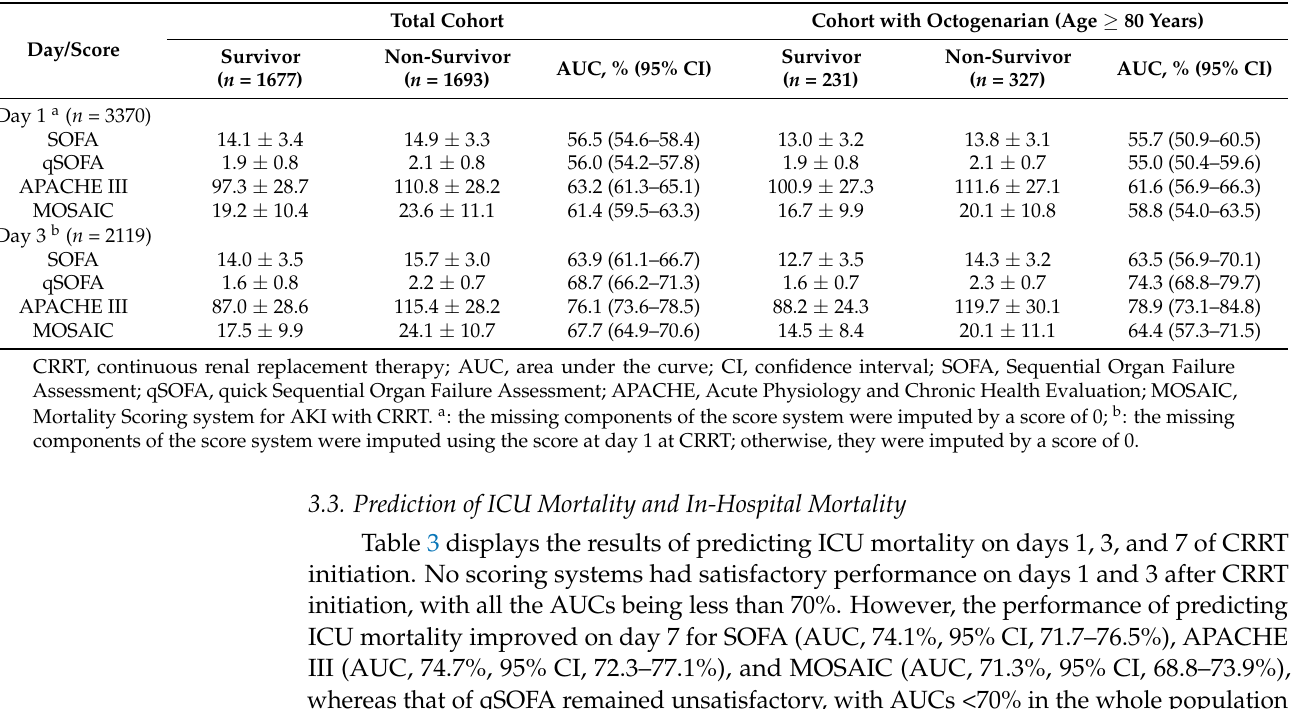
Table 2. Performance of the scoring systems in predicting 7-day mortality since CRRT initiation in the entire cohort and in patients older than 80 years.